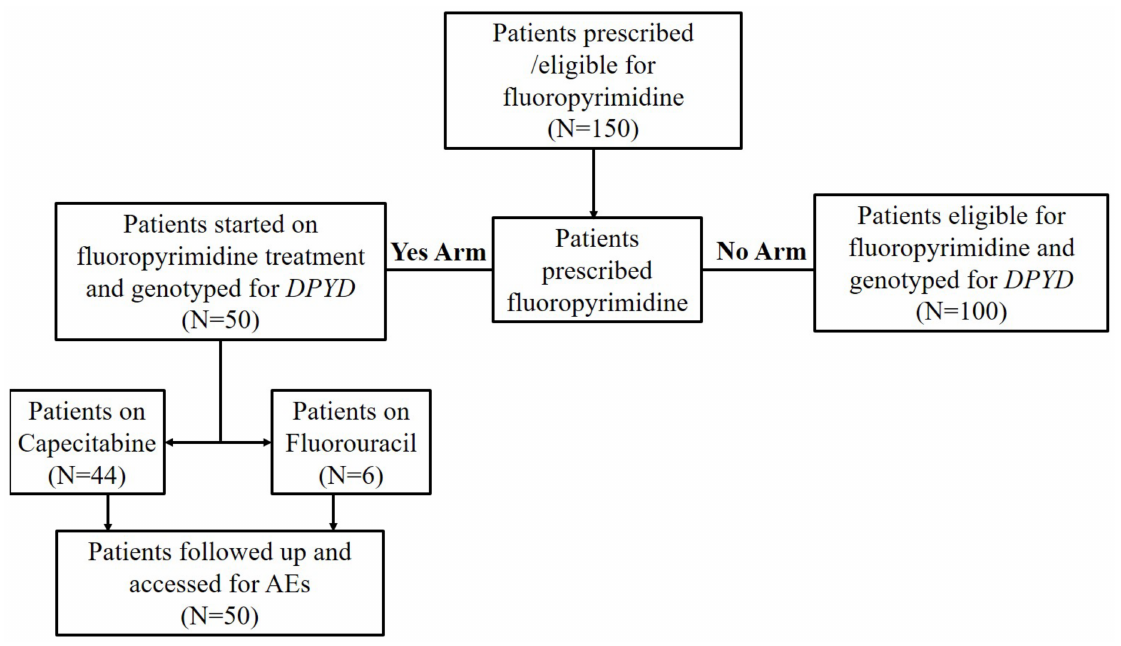
Figure 2. Flow diagram illustrating the study cohort (AEs., adverse events; DPYD. , dihydropyrimi- dine dehydrogenase). Table 1. Characteristics of the